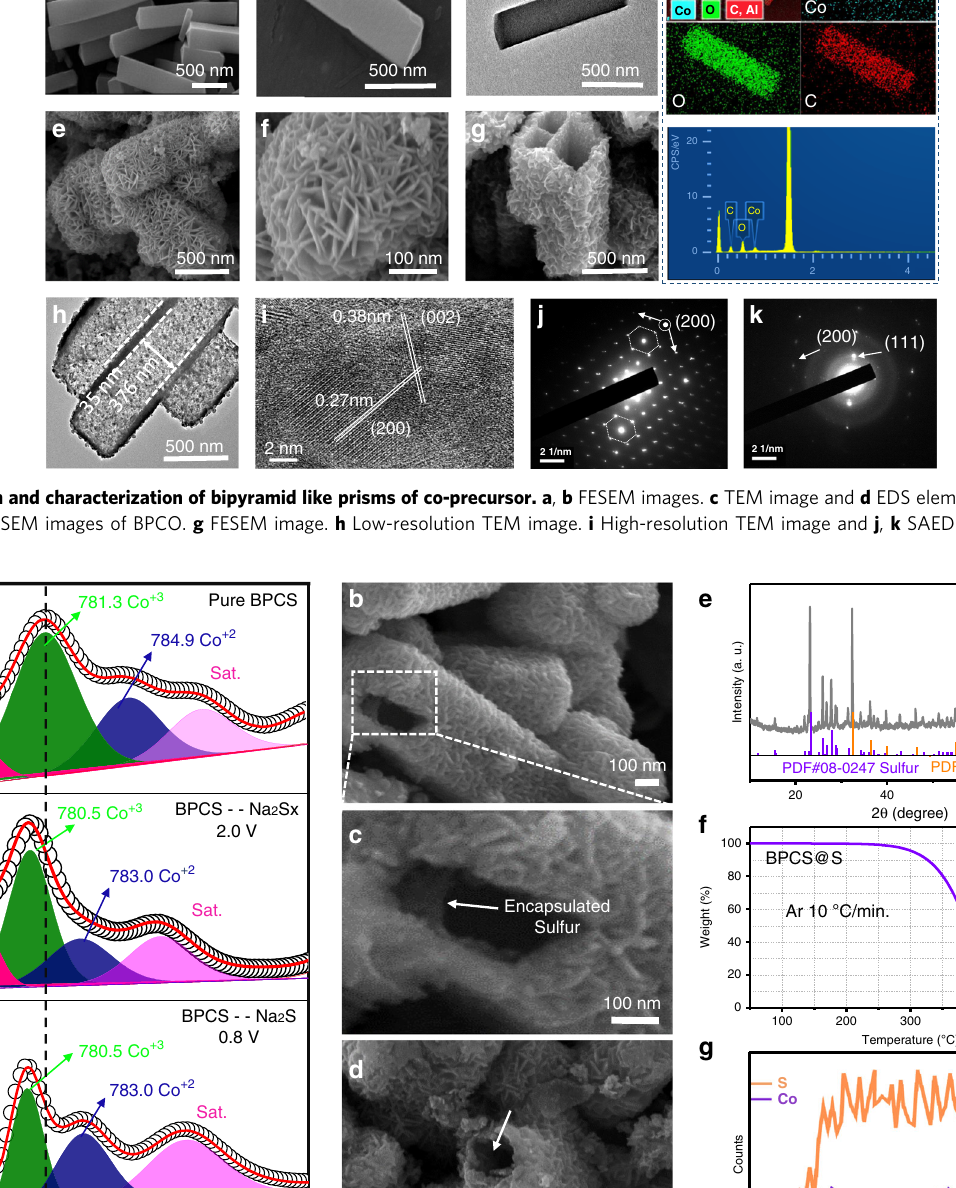
Fig. 13. Finally, sulfur was injected into the hollow prisms using a melt-diffusion method to achieve the S@BPCS composite, as shown in Fig. 3b – d. Figure 3c shows that sulfur ef fi ciently sulfur agglomeration on the hierarchical surface of the BPCS,